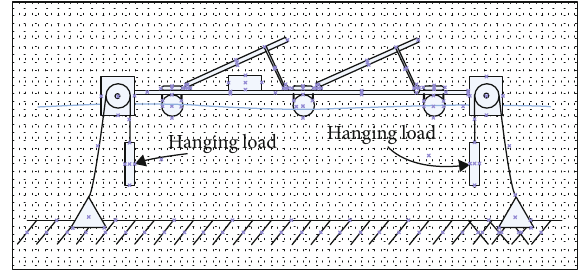
Figure 21: Auxiliary mooring structure for variable water levels